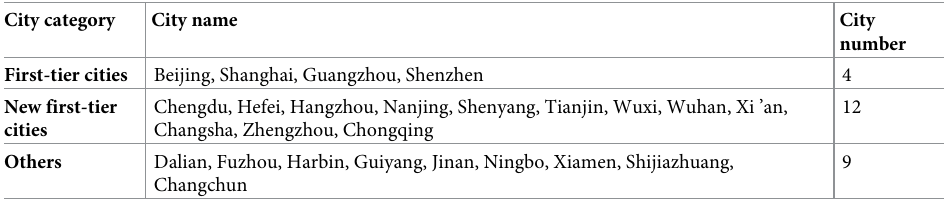
Table 2. Among them, first-tier cities are Beijing, Shanghai, Guangzhou, and Shenzhen, 12 new first-tier cities are Chengdu, Hefei, and Hangzhou, and 9 other cities besides first-tier and confidence cities are Dalian, Fuzhou, and Harbin. The job postings were made in three months between August 2020 and October 2020, with 16,551 online job postings.